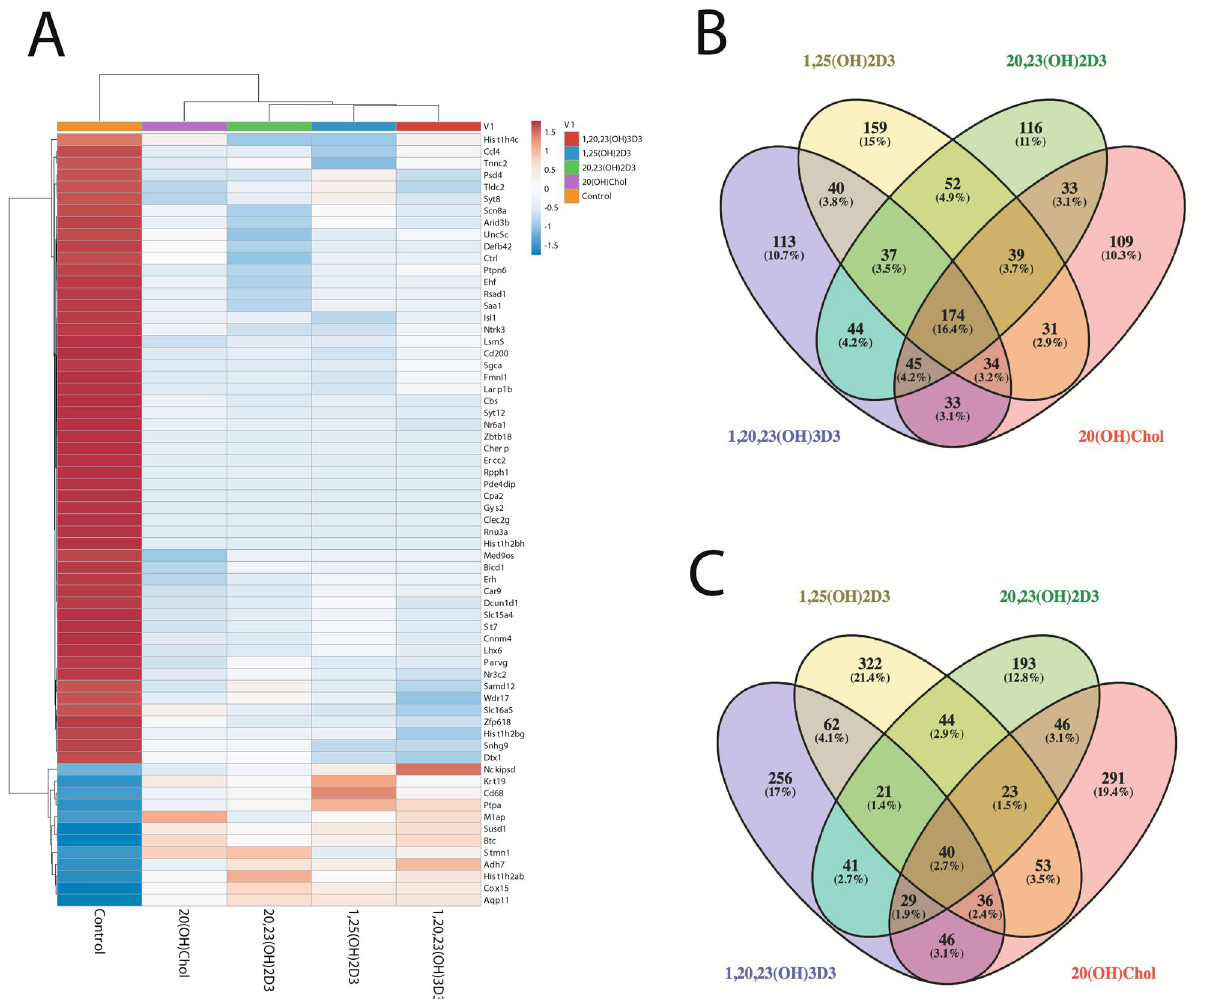
Figure 2. RNAseq analysis of changes in gene expression in murine dermal fibroblasts treated with 10 –7 M 1,25(OH) 2 D3, 20,23(OH) 2 D3, 1,20,23(OH) 3 D3 or 20(OH)cholesterol (20(OH)C, a native LXR ligand) for 24 h. Heat map of the gene expression pattern ( A ) with corresponding Venn diagrams shown for down ( B ) or upnregulated ( C ) protein coding genes for absolute fold change ≥ 2 cutoff. The Venn diagrams were prepared using Venny version 2.1.0: https:// bioin fogp. cnb. csic. es/ tools/ venny/ index. html. The heatmap was prepared using ClustVis: https:// biit. cs. ut. ee/ clust